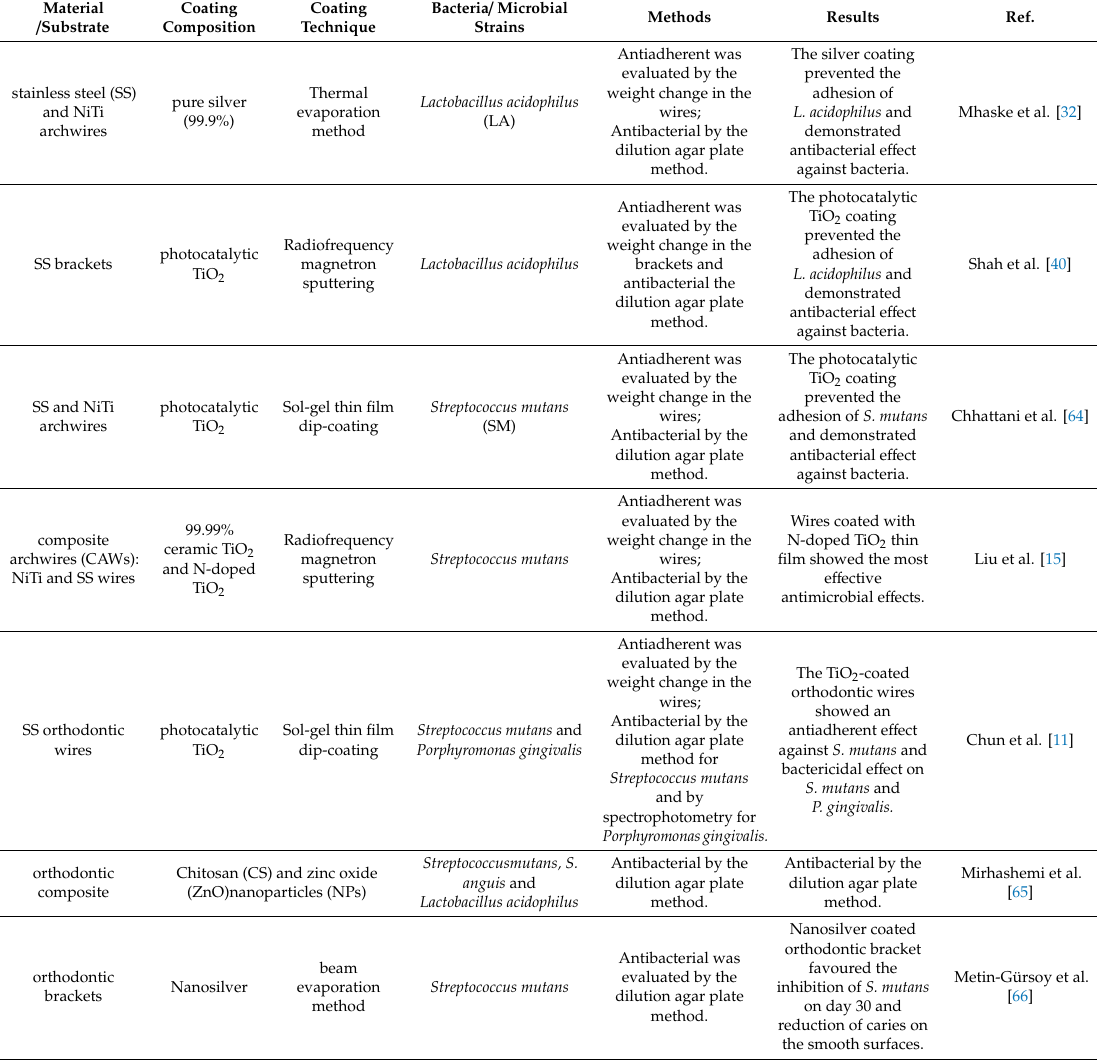
Table 1. Summary on studies on the antiadherent and antibacterial properties of orthodontic materials and coatings for orthodontic